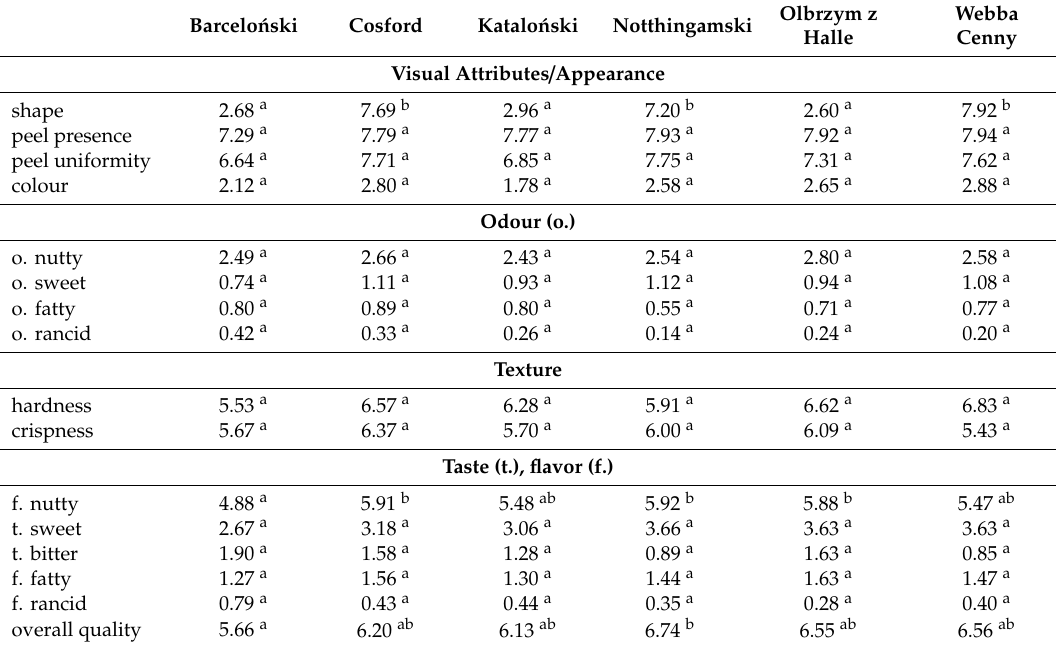
Table 4. Sensory characteristics of row nuts —the mean values, two sessions ( n = 20). Barcelo´nski Cosford